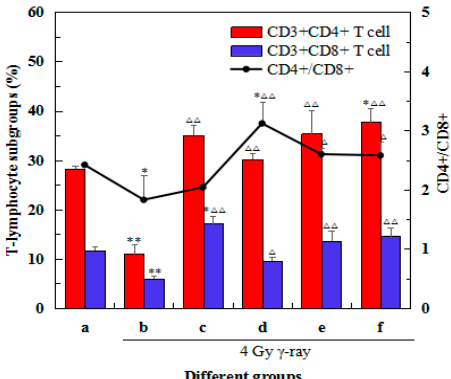
Figure 5. Effects of 5 ′ -AMP on the changes in spleen lymphocyte subsets (CD3 + CD4 + and CD3 + CD4 + ) after irradiation. (a) Group I: Normal group; (b) Group II: Model group; (c) Group III: Positive control (berberine hydrochloride); (d) Group IV: Radiation + 5 ′ -AMP (0.08 g/kgBW/day); (e) Group V: Radiation + 5 ′ -AMP (0.16 g/kgBW/day); (f) Group VI: Radiation + 5 ′ -AMP (0.64 g/kgBW/day). * p < 0.05 and ** p < 0.01 compared with the normal group; Δ p < 0.05 and ΔΔ p < 0.01 compared with the model group.